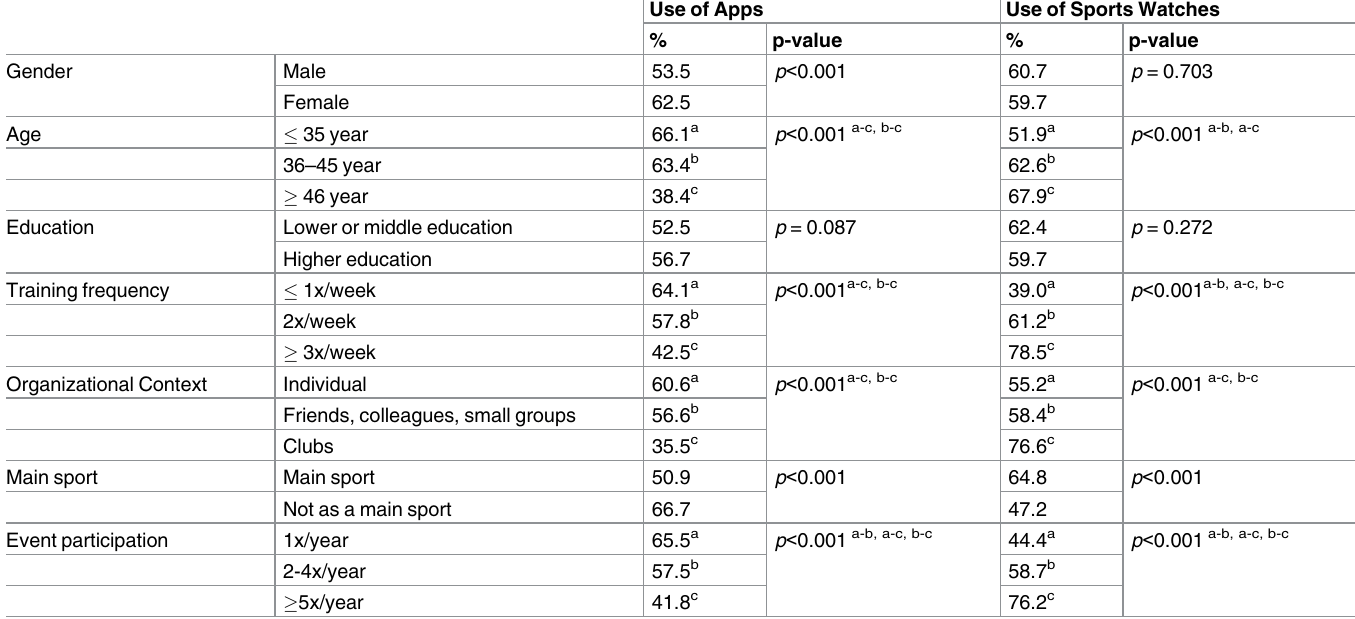
Table 3. Results of chi-squared test with post hoc testing for event runners’ usage of apps and sports watches for the socio-demographic vari- ables and running-related characteristics, in percentages.